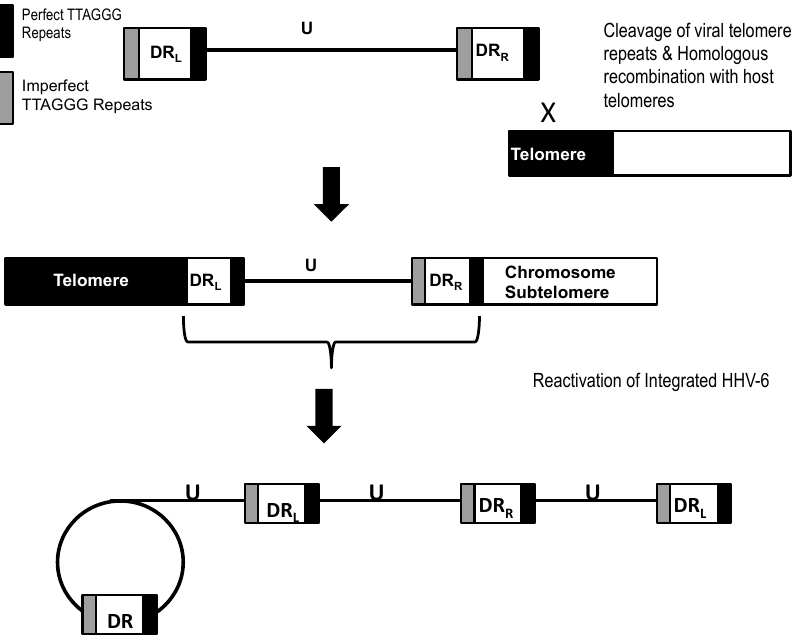
Figure 2. Model for integration and reactivation of HHV-6. The linear genome of HHV-6 integrates into the telomeres of the host chromosome, and during reactivation the integrated genome is liberated from the host chromosome, forming a circular intermediate. Rolling circle replication of the circular intermediate generates concatemers of the viral genome.